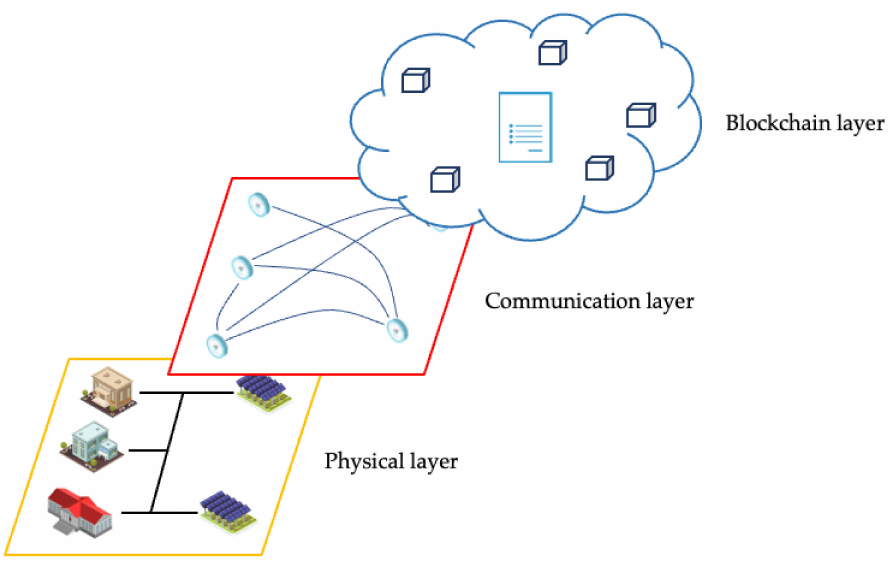
Figure 1. Illustration of the different layers of the proposed